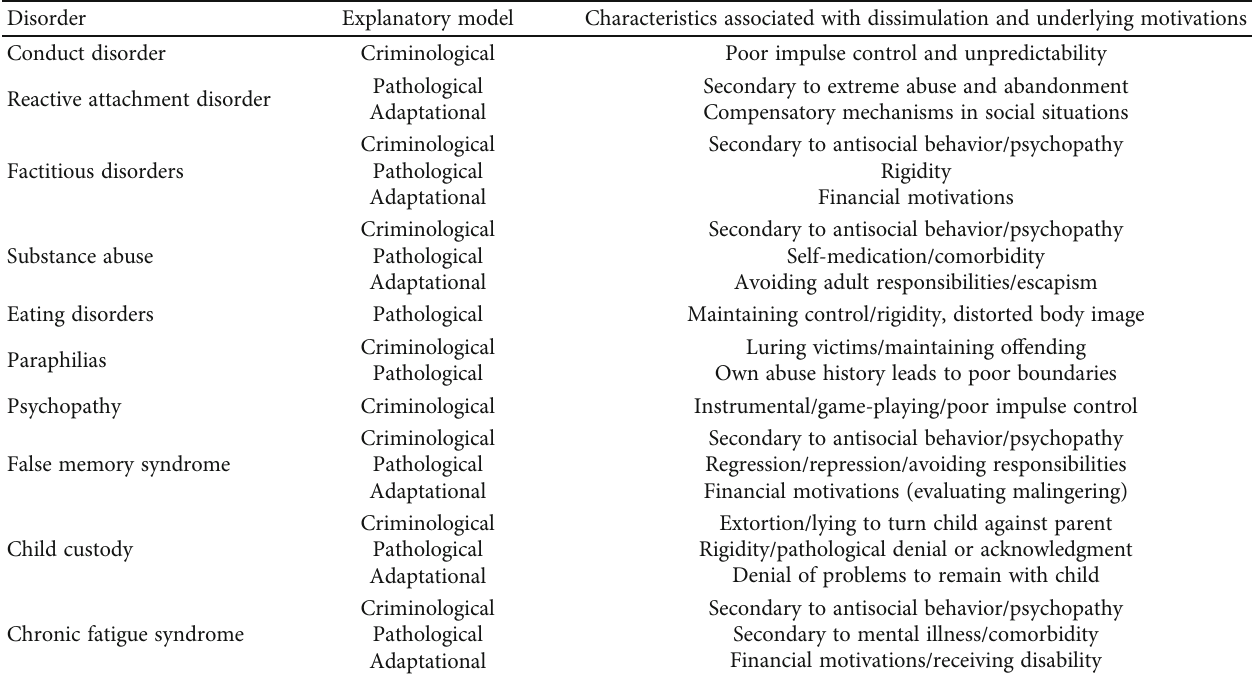
Table 4: Dissimulation in connection to speci fi c conditions and underlying motivations